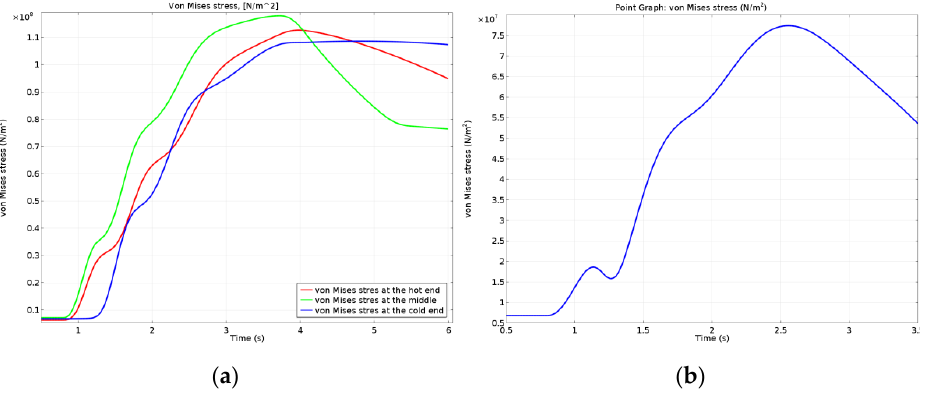
Figure 27. von Mises stress variation in time for: ( a ) drum; ( b ) disc.